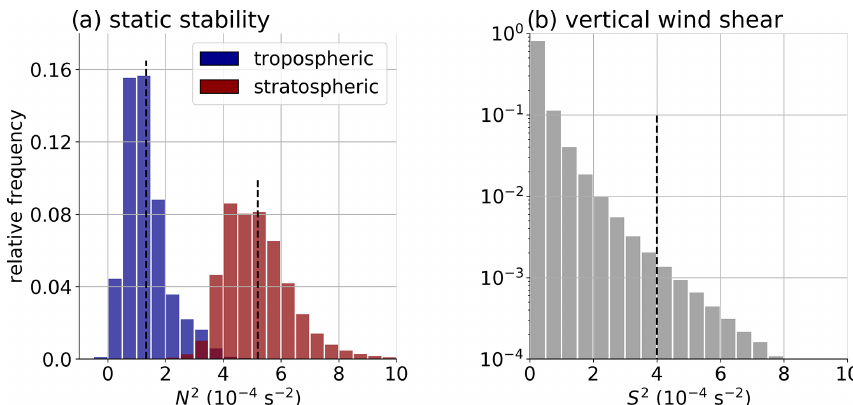
Figure 1. Relative occurrence frequency histogram of static stability N 2 and vertical wind shear S 2 from 1.5km above the surface up to 25km altitude on 11 September 2017 at 00:00UTC over the Northern Hemisphere. Counts are weighted with the grid box volumes. (a) Static stability ( N 2 , in 10 − 4 s − 2 ). Blue indicates values in the troposphere ( z < z( LRT ) ), and red values in the stratosphere ( z < z( LRT ) ). Dashed black lines indicate average tropospheric/stratospheric N 2 . (b) Relative occurrence frequency distribution of vertical wind shear ( S 2 , in 10 − 4 s − 2 ). Logarithmic occurrence frequency scale. Dash black line indicates threshold value S 2 t .